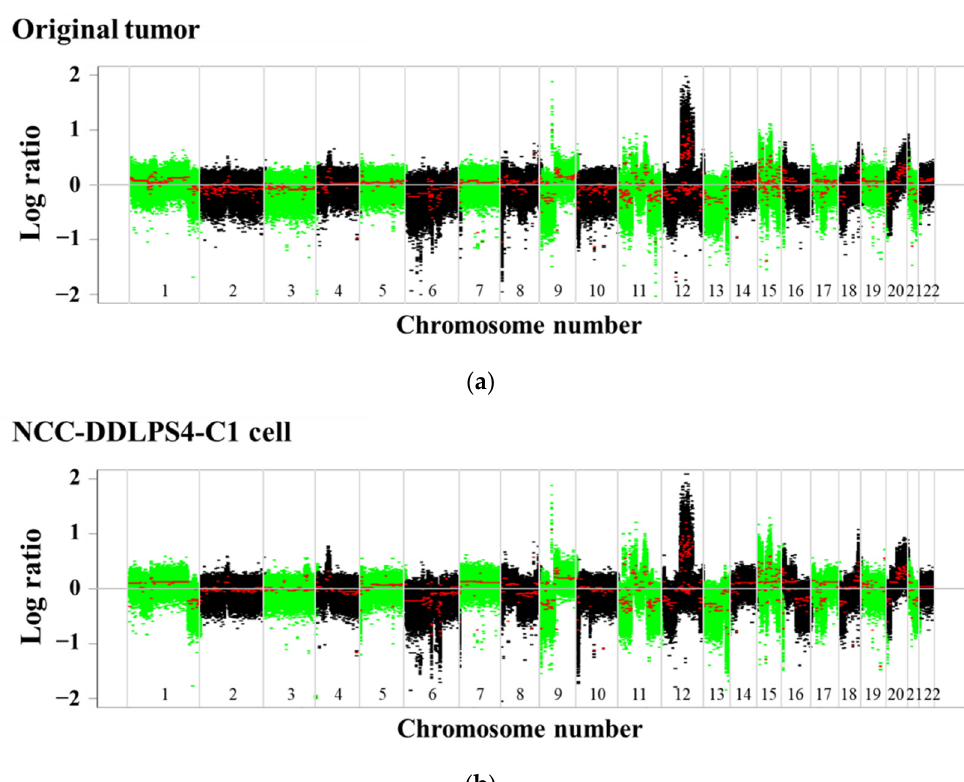
Figure 2. Single-nucleotide polymorphism (SNP) array analysis. Copy number alterations in ( a ) the original tumor and ( b ) NCC-DDLPS4-C1 cells were demonstrated. The X -axis indicates the log ratio of copy number. Y -axis indicates chromosomal location. The characteristic amplification of chromosome 12 was